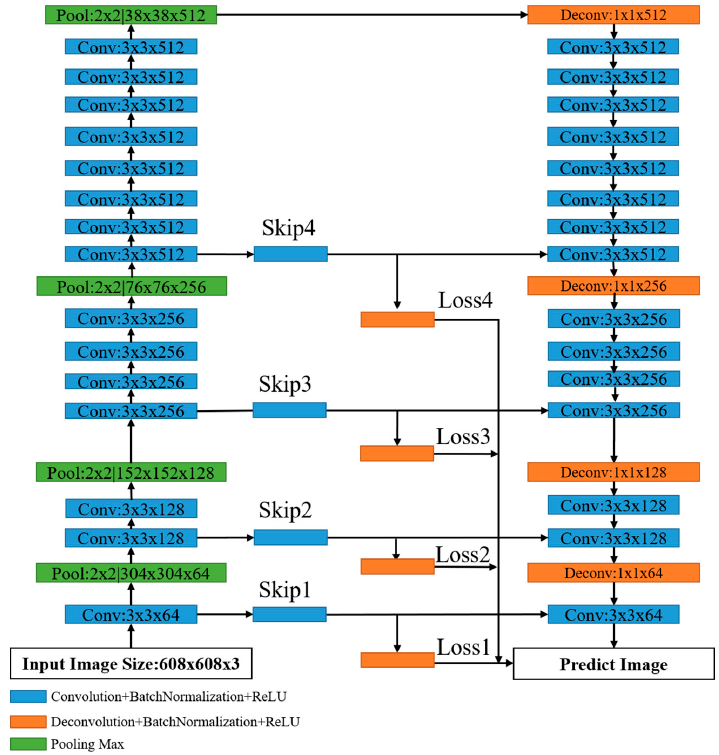
Figure 2. Details of crack detection on dam surface (CDDS) network structure.